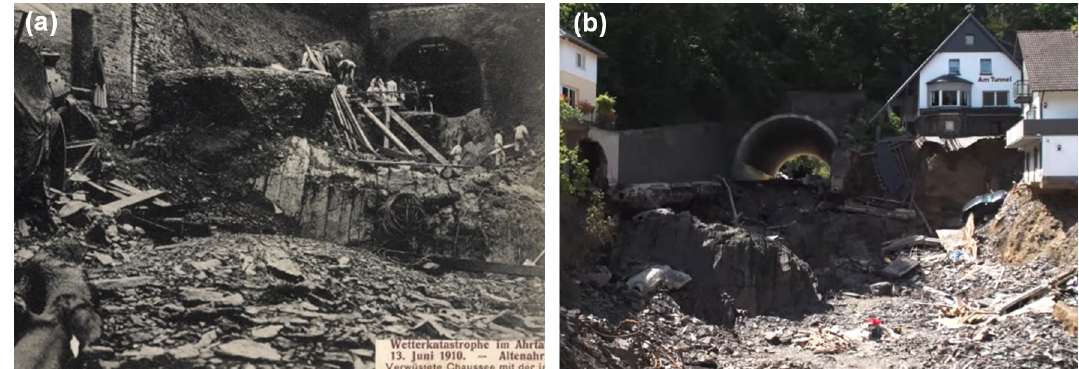
Figure 8. Downstream end of the road tunnel in Altenahr after (a) the flood of 1910 (photo credits: Kreisarchiv Ahrweiler ) and (b) the flood of 2021 (photo credits: Dieter